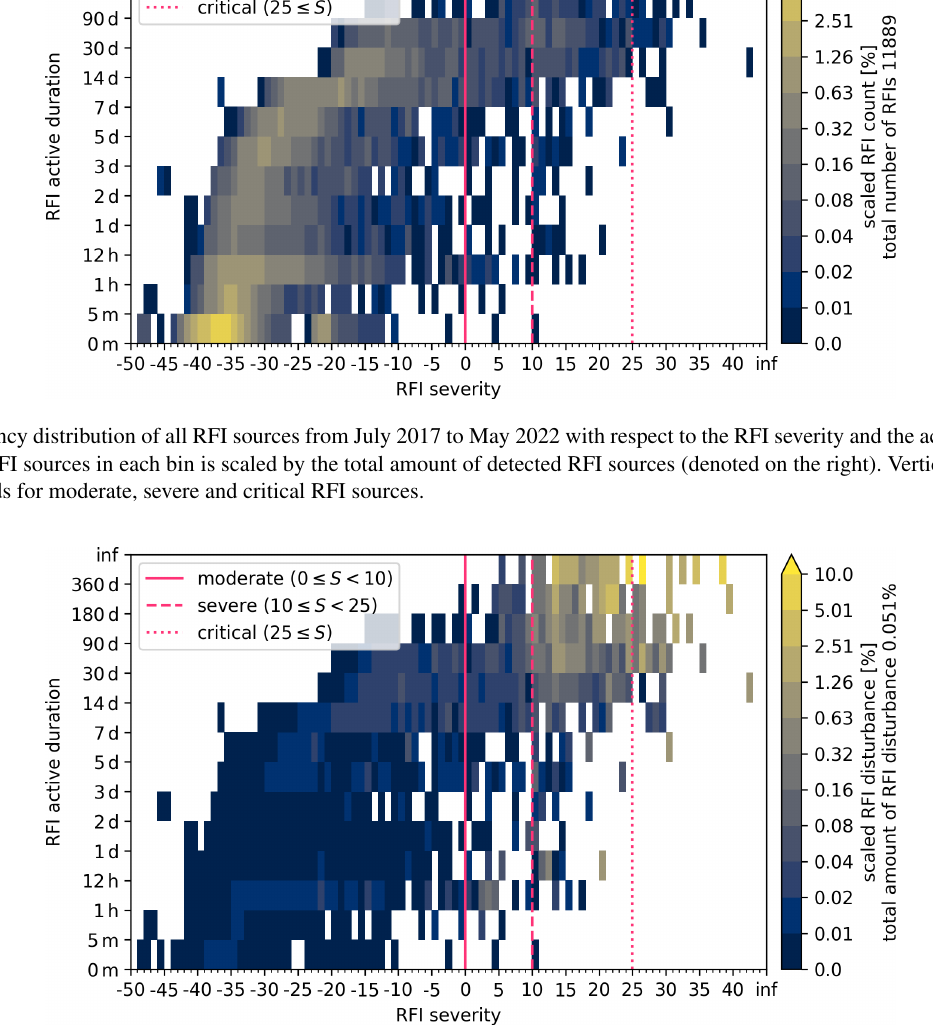
Figure 8. Heatmap of aggregated disturbance caused by RFI sources from July 2017 to May 2022 with respect to the RFI severity and the active RFI duration. The percentage of compromised rays aggregated in each bin is scaled by the total amount of caused disturbances (denoted on the right). Vertical lines mark RFI severity thresholds for moderate, severe and critical RFI